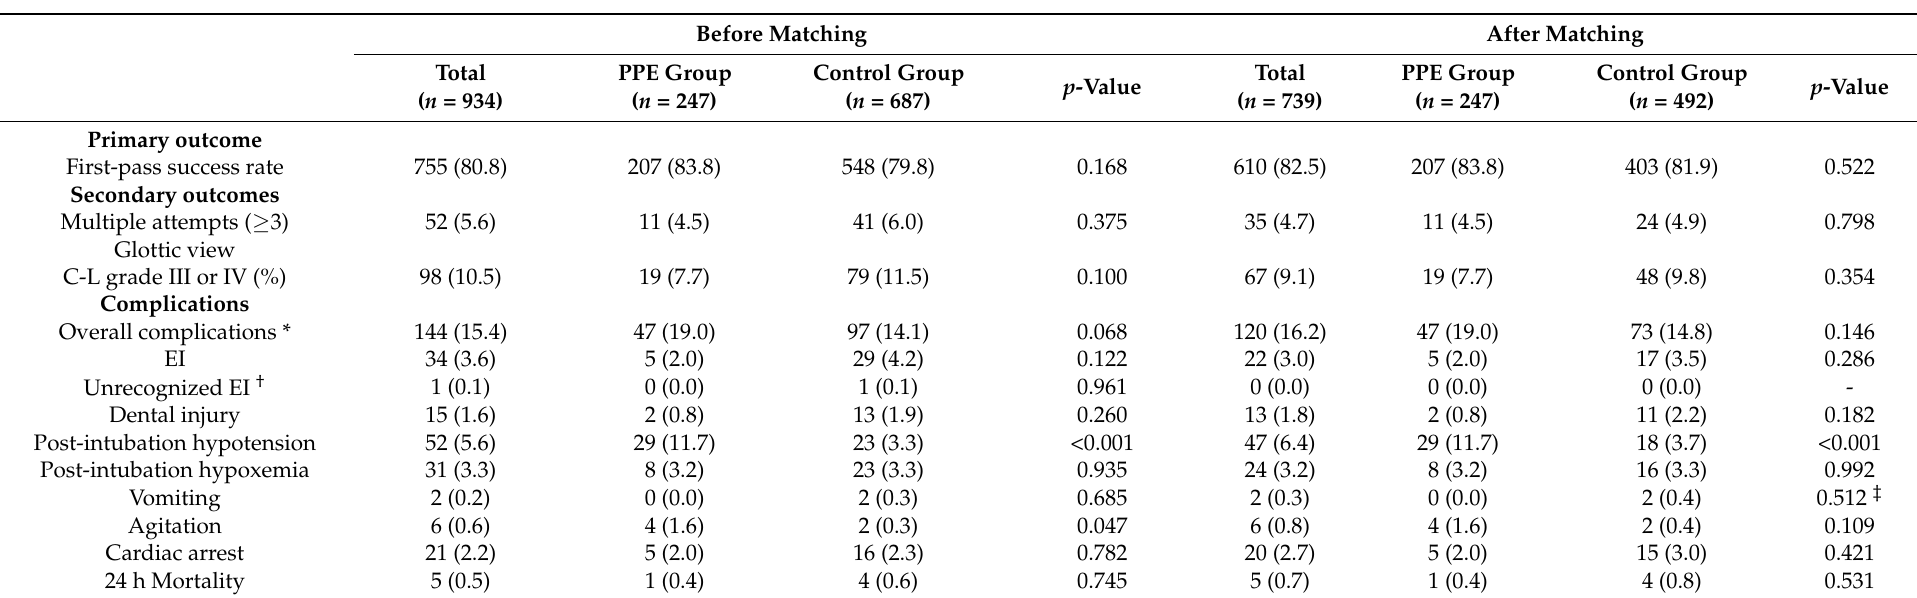
Table 2. Primary and secondary